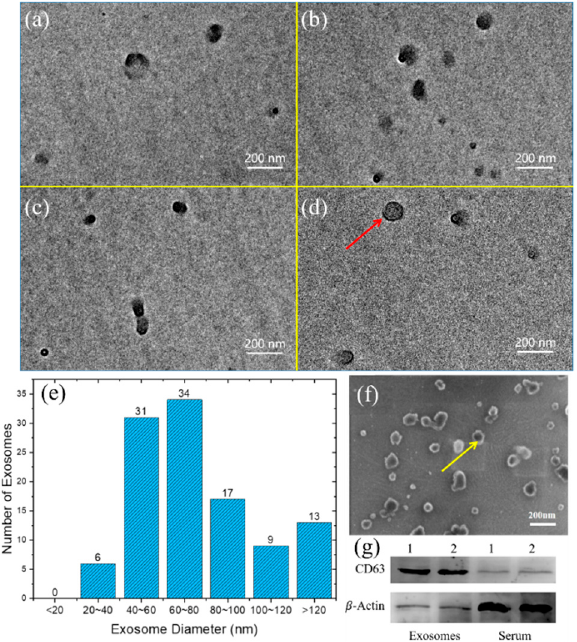
Figure 10. Identification and characterization of isolated exosomes using ( a – d ) TEM. Red arrow: the isolated exosomes contain typical membrane structure after negative dyeing treatment. ( e ) Quantitative size analyses: more than 95% of the obtained particles are between 30 and 150 nm. ( f ) SEM. Yellow arrow: round bowl-shaped morphology of the isolated exosomes can be observed. ( g ) Western blot. Western blot of CD63 and β -actin protein expression in isolated exosomes and serum lysates from two